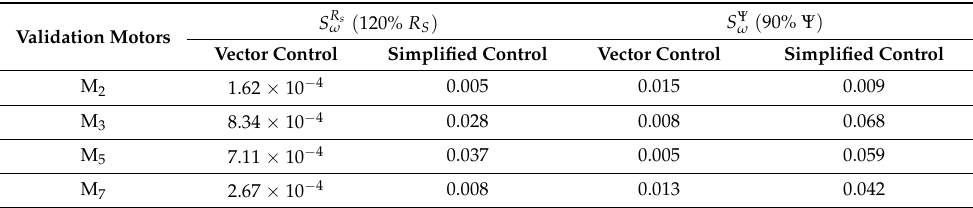
Table 4. Sensitivity